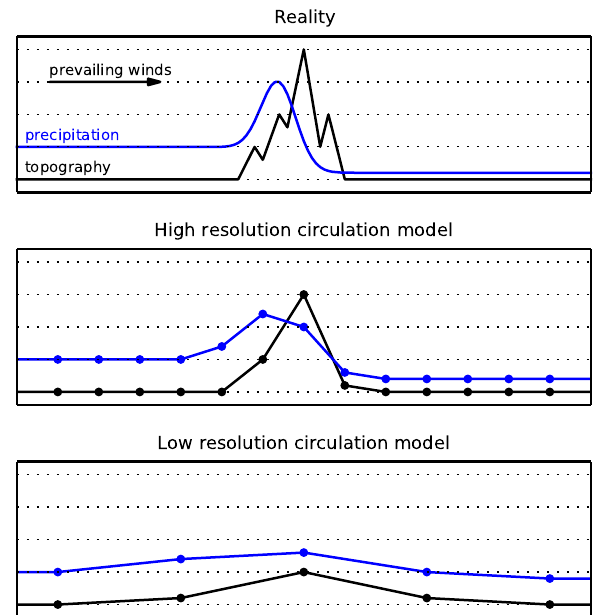
Figure 12. Schematic representation of the orographic precipita- tion effect over a mountain range. In a GCM of low resolution, the precipitation peak appears downwind shifted and smoother and the precipitation shadow is less pronounced than in a high-resolution